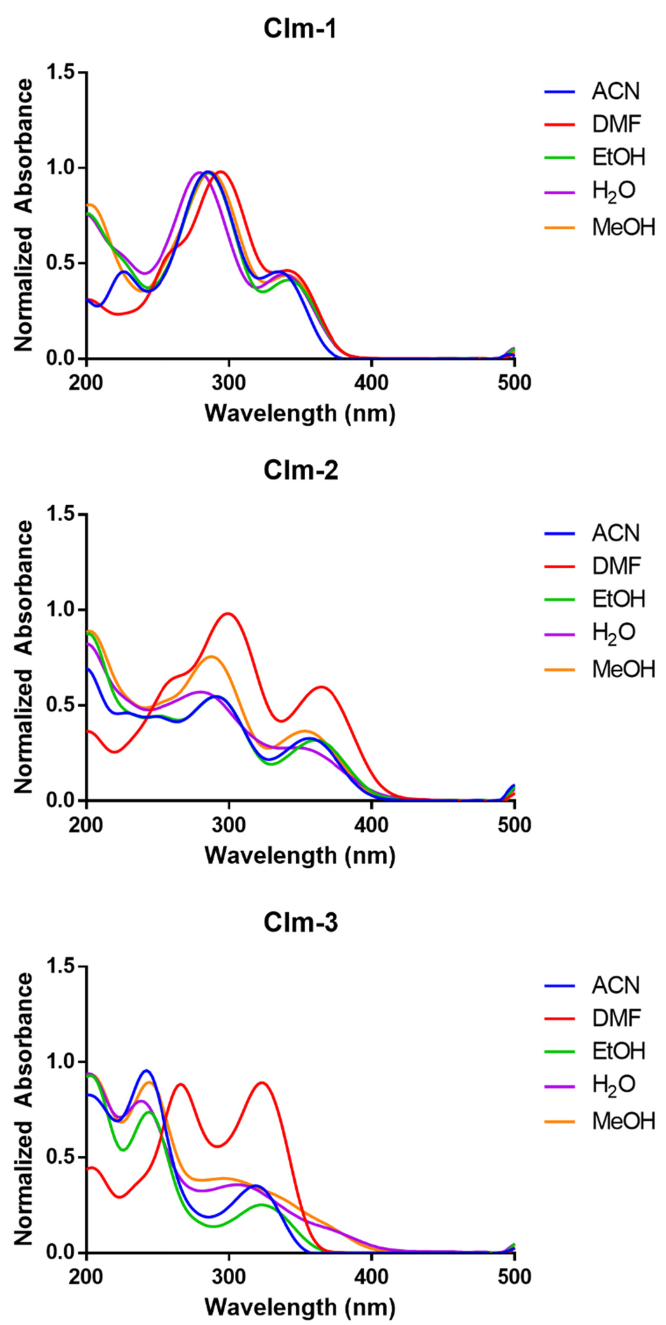
Figure 1. Normalized absorption spectra of Clm-1-3 in protic (H 2 O, EtOH, and MeOH) and aprotic (ACN and DMF) solvents, with final concentration of 30 µM for all compounds.